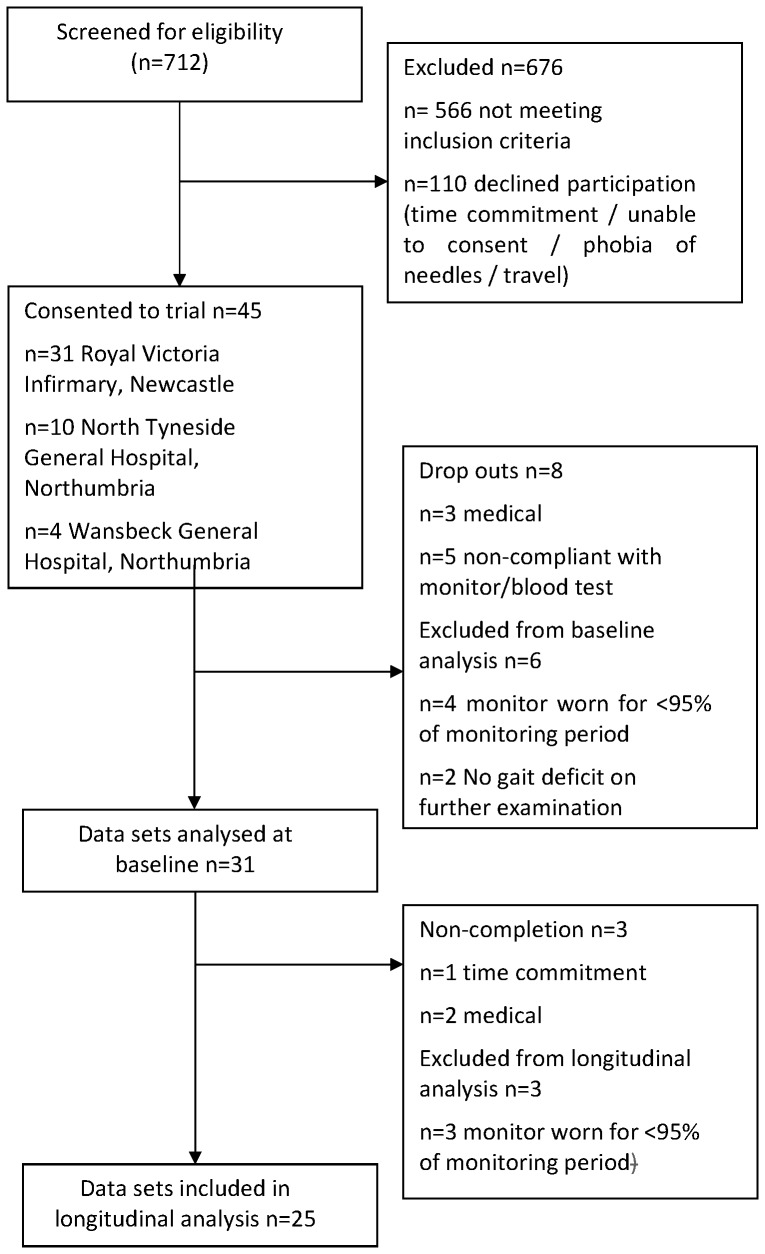
CONSORT flow diagram of trial recruitment, drop out and completion.